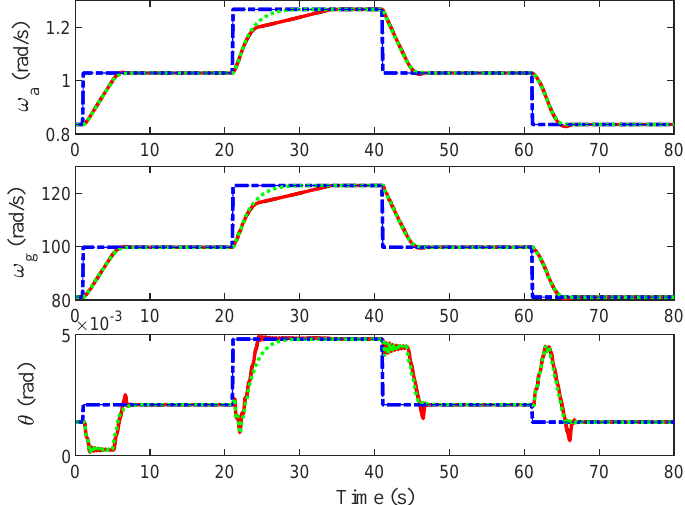
Figure 7. States ω a , ω g and θ for the proposed EMPC 1 (black dash-dotted line), EMPC 2 (red solid line) and classical tracking MPC (green dashed line) under gradient